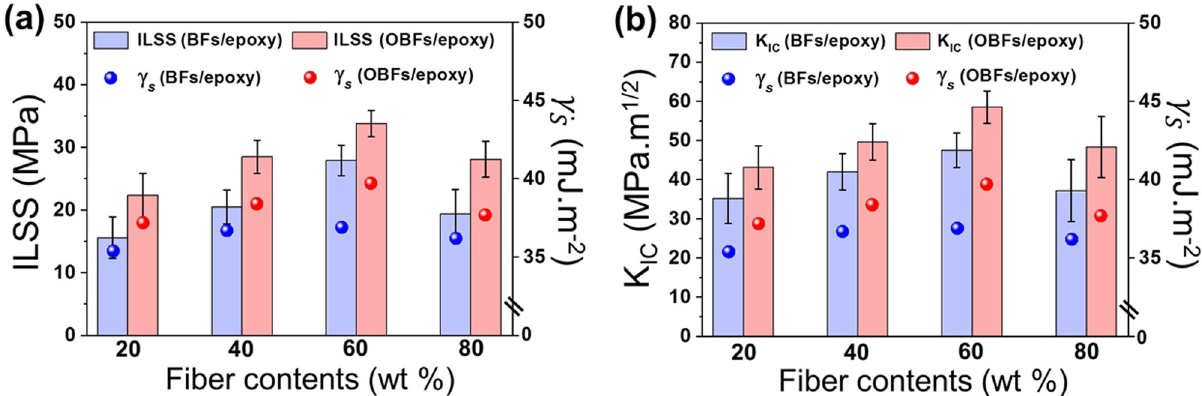
Figure 5: Mechanical properties of BFs/epoxy and OBFs/epoxy composites: ( a ) ILSS and ( b ) fracture toughness.